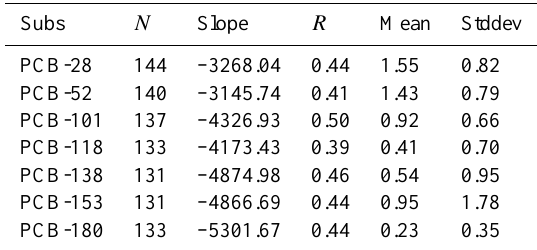
Table 1. Number of samples ( N ), slopes of partial pressure ver- sus reciprocal absolute temperature, correlation coefficient ( R ), mean concentration and standard deviation of seven PCB congeners [pgm − 3 ], for the years 2004–2007 measured at Birkenes.